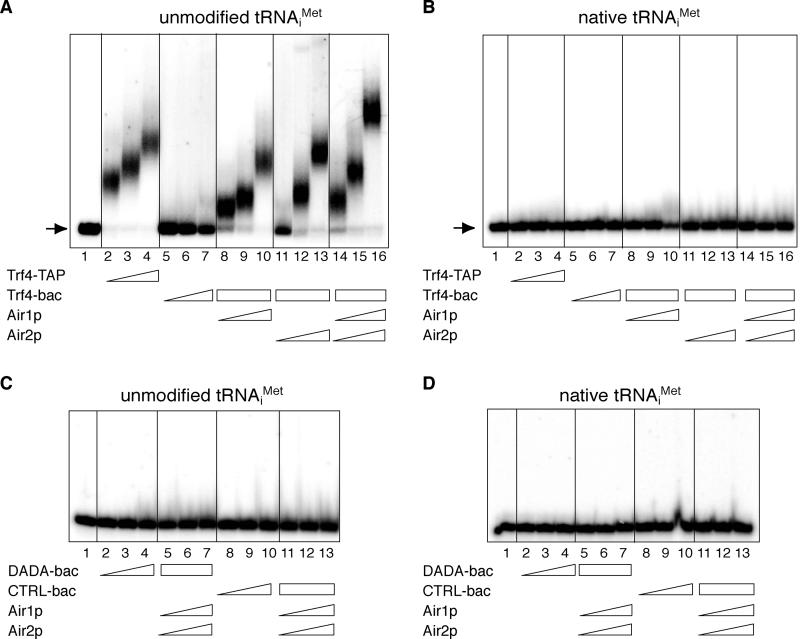
In Vitro Reconstitution of Trf4 Complex from Recombinant ProteinsPolyadenylation assays were performed with radiolabeled unmodified (A and C) and native (B and D) tRNAi
Met substrate incubated with 25, 50, or 100 ng of Trf4-TAP complex (Trf4-TAP; A and B), or with 5, 10, or 20 ng of recombinant Trf4 protein expressed in the baculovirus system (Trf4-bac; A and B), or with 5, 10, or 20 ng of mutant Trf4-bac (DADA-bac; C and D), or with equal amounts and dilutions of control eluates (CTRL-bac; proteins from cell lysates that unspecifically bound to the Ni2+-NTA matrix; C and D). In reconstitution experiments 20 ng of Trf4-bac, or DADA-bac, or control eluates were mixed with 0.5, 3, or 15 ng of recombinant Air1p and/or recombinant Air2p in the combinations indicated. The proteins were pre-incubated for 30 min on ice to allow for binding. Reactions were incubated for 50 min at 30 °C. Control reactions contained no protein (lane 1 in each gel).